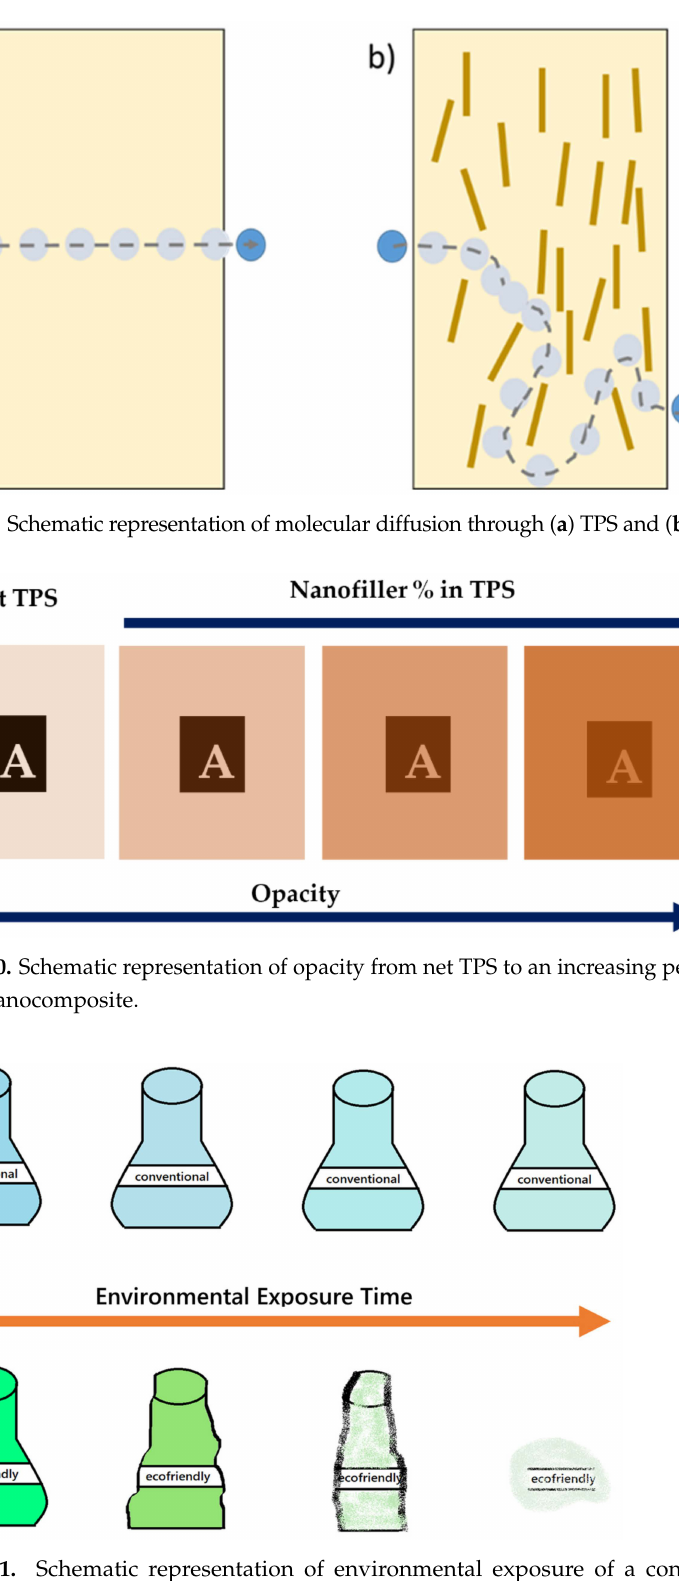
Figure 11. Schematic representation of environmental exposure of a conventional and green (ecofriendly) container with the increase on the environmental exposure